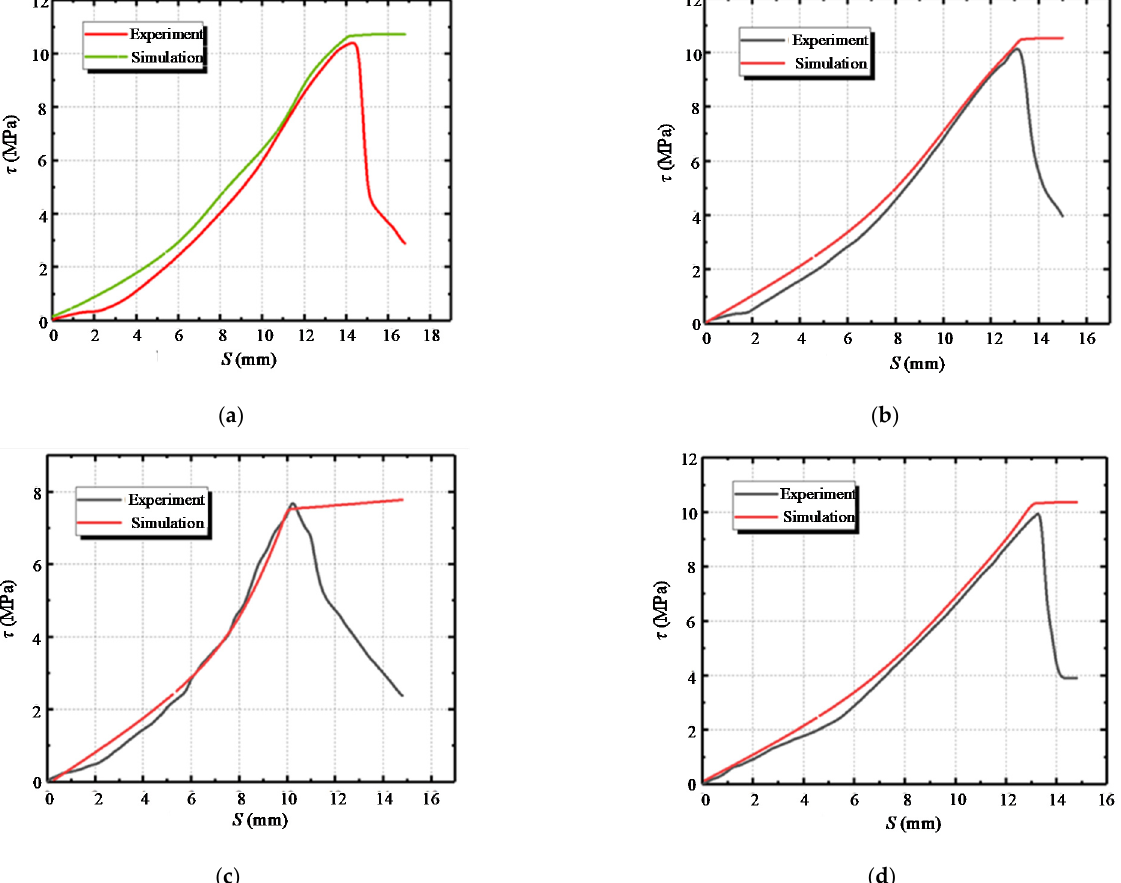
Figure 18. Comparison of bond–slip diagrams for the experiment and simulation: ( a ) C100-5-0; ( b ) C100-5-15; ( c ) C100-5-30; ( d ) C150-5-0.